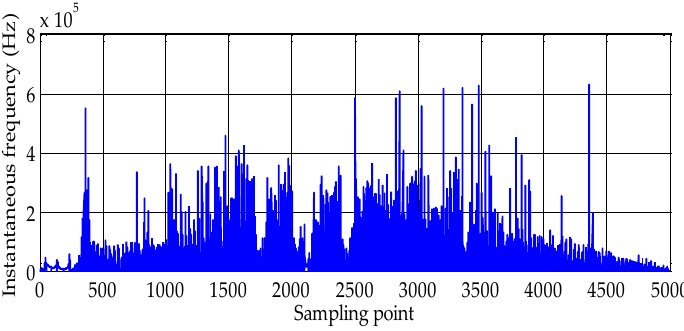
Figure 11. Test result of the Hilbert–Huang transform (HHT) method.